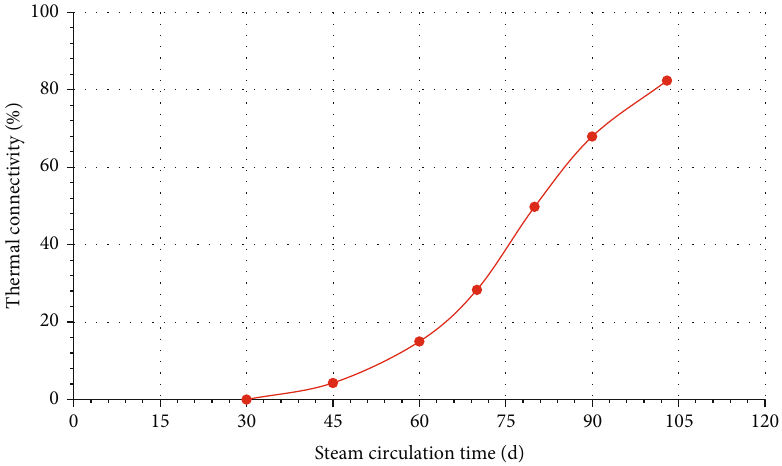
Figure 11: Thermal connectivity ratio obtained by tracking numerical simulation.